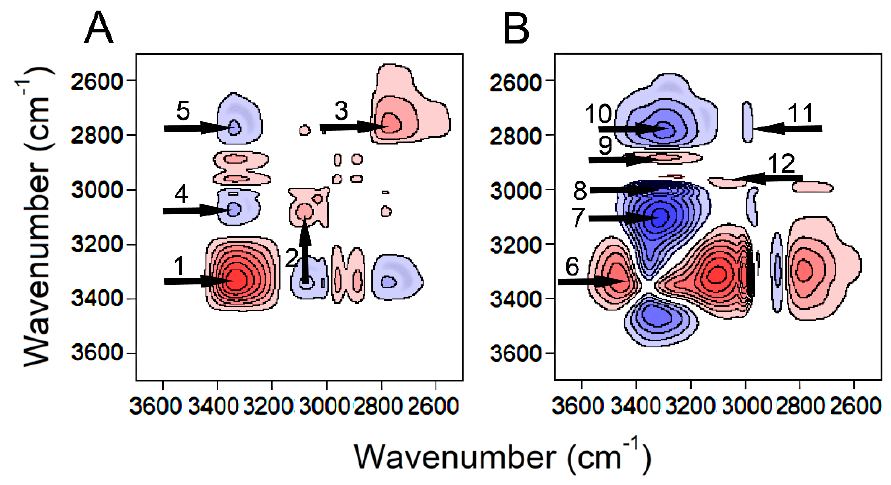
Figure 5. Synchronous ( A ) and asynchronous ( B ) 2D-correlation spectra contour maps of ν (O ‒ H) and ν (C ‒ H) in the process of increasing concentration of ZnCl 2 . Red and blue maps represent positive and negative correlation intensities, respectively.